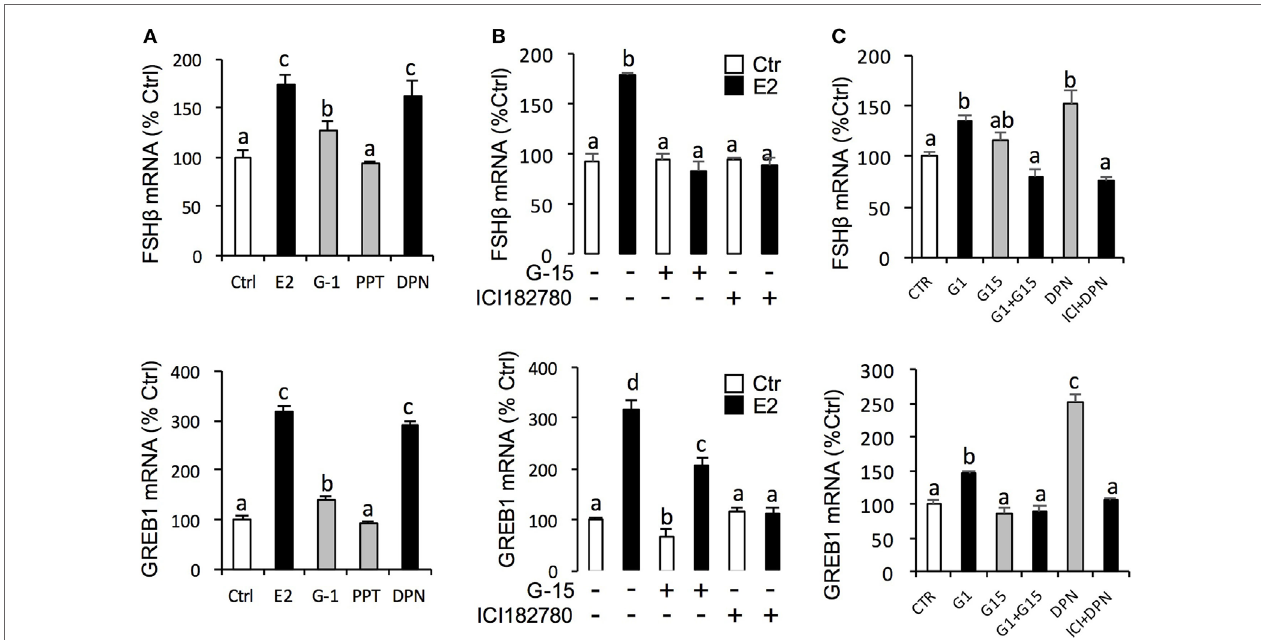
FigUre 5 | Receptor specificity of E2-induced follicle-stimulating hormone (FSH) β and growth regulation by estrogen in breast cancer 1 (GREB1) mRNA expression. (a) Effects of ER agonists on FSH β and GREB1 mRNA expression. Pituitary cells were treated for 24 h with E2 (10 nM), G protein-coupled estrogen receptor (GPER) agonist G-1 (1 µM), estrogen receptor alpha agonist propylpyrazole triol (PPT) (1 µM), and ER β agonist DPN (1 µM), respectively. (B) Effects of GPER antagonist G-15 and ER antagonist ICI182780 on E2-induced FSH β and GREB1 mRNA expression. Pituitary cells were treated for 24 h with E2 (10 nM) in the presence or absence of the G-15 (10 µM) or ICI182780 (10 µM), respectively. (c) Effects of GPER antagonist G-15 or ER antagonist ICI182780 on G-1- or DPN-induced FSH β or GREB1 mRNA expression. Grass carp pituitary cells were incubated for 24 h with GPER agonist G1 (1 µM) in the presence or absence of G-15 (10 µM), or ER β agonist DPN (1 µM) in the presence or absence of ICI182780 (10